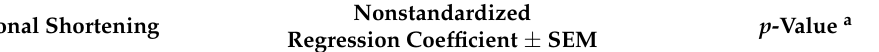
Table 3. Forward stepwise ridge regression analysis of predictors of LV midwall fractional shortening in patients with P-LFLG-AS compared to NFHG-AS adjusted for estimates of LV afterload (cESS) and preload